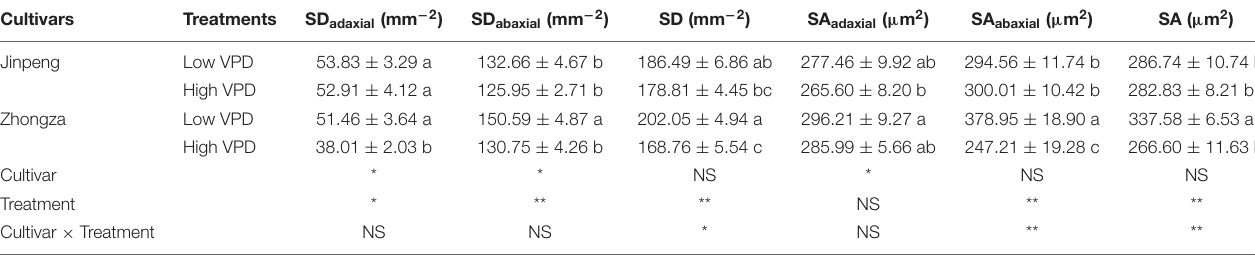
FIGURE 1 | Transpiration rate at the canopy (E canopy ) (A) and leaf level (E leaf ) (B) , stomatal conductance at the canopy (g s - canopy ) (C) and leaf level (g s - leaf ) (D) for two tomato cultivars, Jinpeng and Zhongza, grown under low (1.1–1.5 kPa) and high (2.2–2.6 kPa) VPD. Data are means ± standard error ( n = 5 plants). Different letters denote statistically significant differences (Duncan’s test, P < 0.05). Two-way ANOVA was used to estimate the effect of cultivar (C), treatment (T), and their interaction (C × T) ( ∗∗ P < 0.01; ∗ P < 0.05; NS, not significant). TABLE 1 | Stomatal density (SD) and area (SA) for two tomato cultivars, Jinpeng and Zhongza, grown under low (1.1–1.5 kPa) and high (2.2–2.6 kPa)